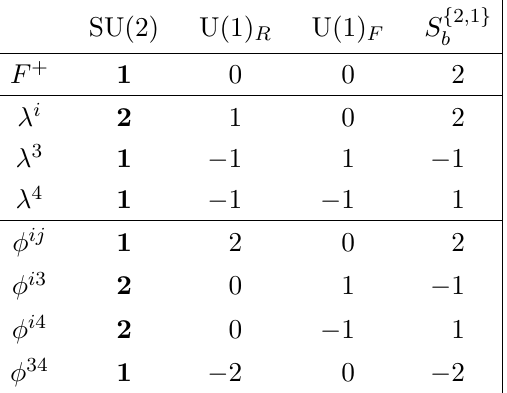
Table 5 . The charges carried by the component (cid:12)elds of the N = 4 super Yang-Mills multiplet under the S f 2 ; 1 g S-fold operator (in units of (cid:25)=k ) and the invariant SU(2) (cid:2) U(1) R (cid:2) U(1) F (cid:26) SU(4) b (cid:13)avour/R-symmetry